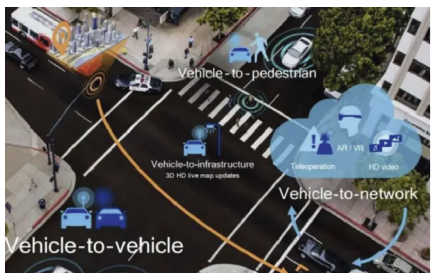
Figure 1: The application scenario diagram of the VLC commu- nication system for intelligent